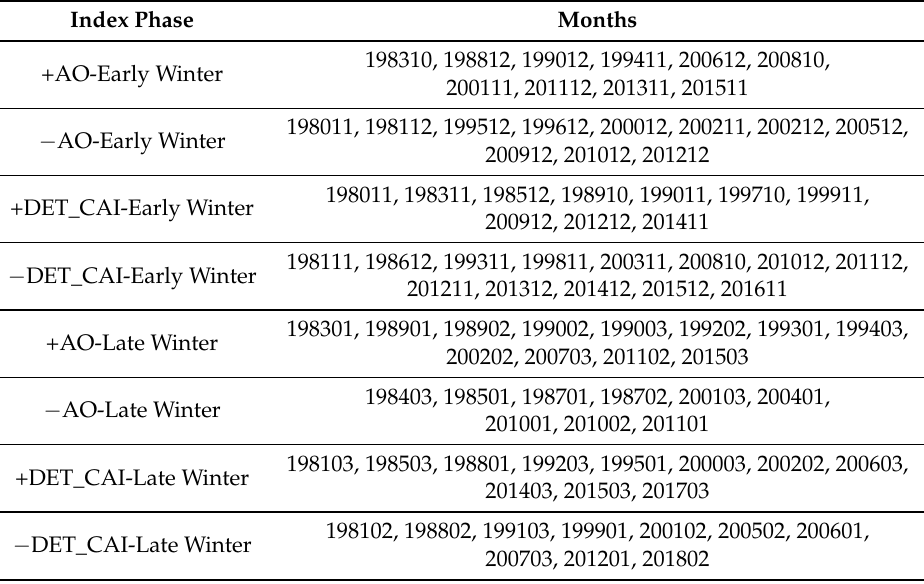
Table 1. Selected Months for Composite